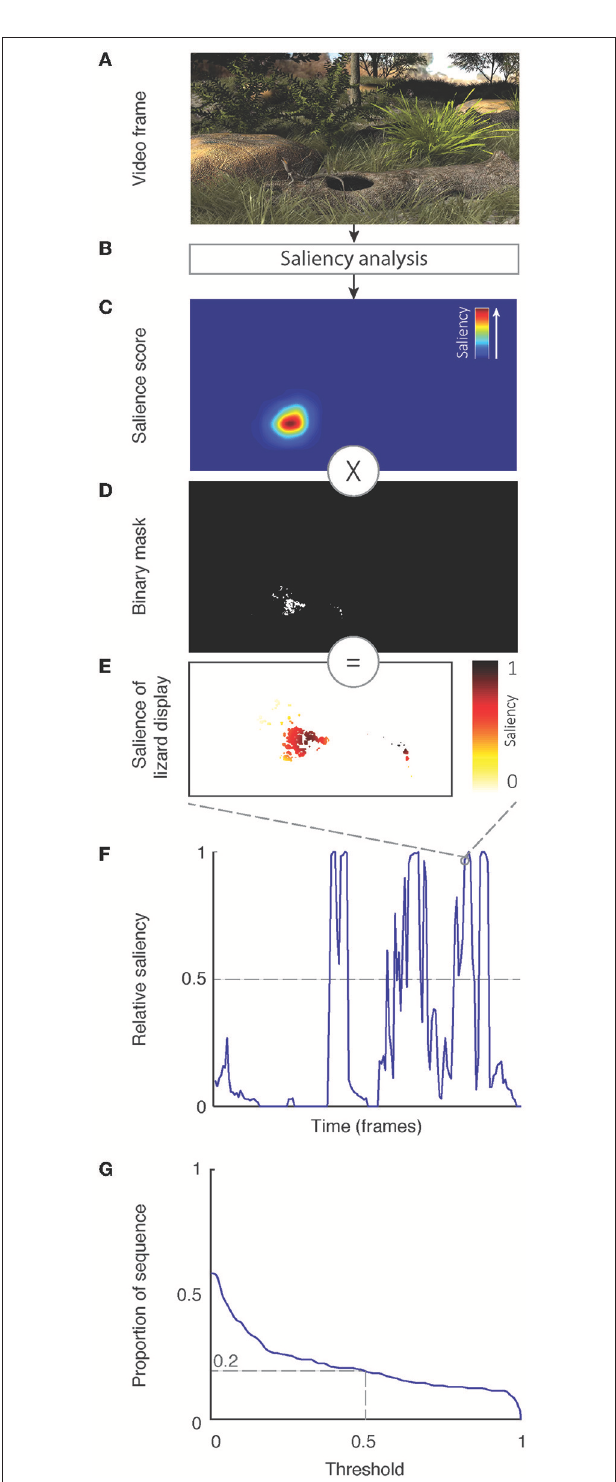
FIGURE 5 | A schematic representation of our analytical approach to quantifying effectiveness of lizard displays in the animation sequences we created. Frames from the animation sequence (A) are analyzed using saliency analysis ( B ; see text for details) to yield a salience score in the range [0,1] for